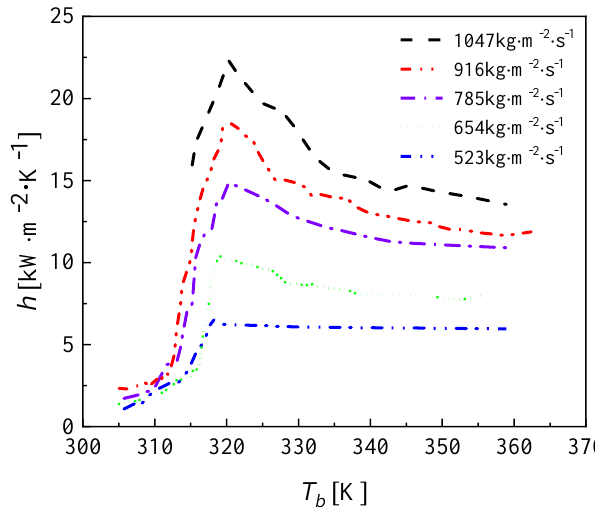
Figure 13. Variation in the heat transfer coefficient of CO 2 at different mass fluxes.